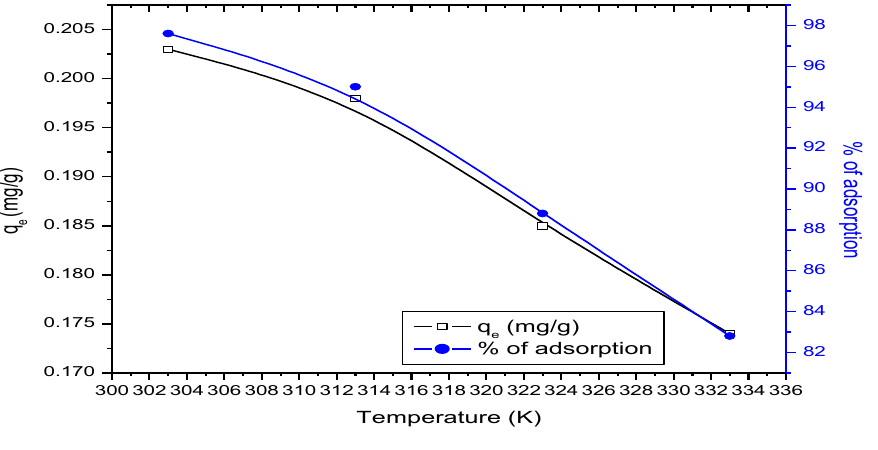
Figure 10. Effect of temperature on the adsorption of fluoride by eggshell powder (experimental conditions: Initial fluoride concentration: 5.0 mg/L, pH: 6.0, adsorbent dose: 2.4 g/100ml and particle size 150µm, agitation speed: 350 rpm, Temperature: 303